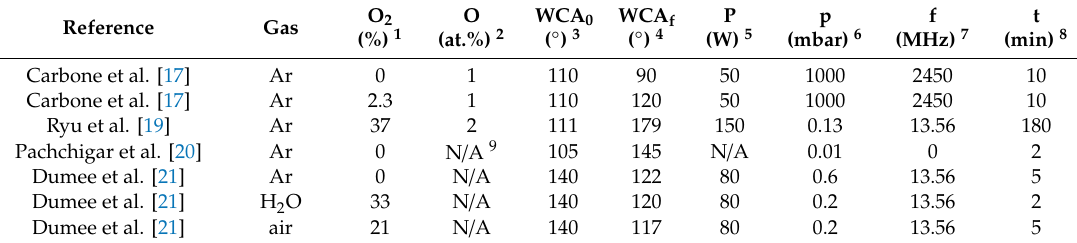
Table 1. Summary of treatment parameters and surface finish of polytetrafluoroethylene (PTFE) reported by di ff erent